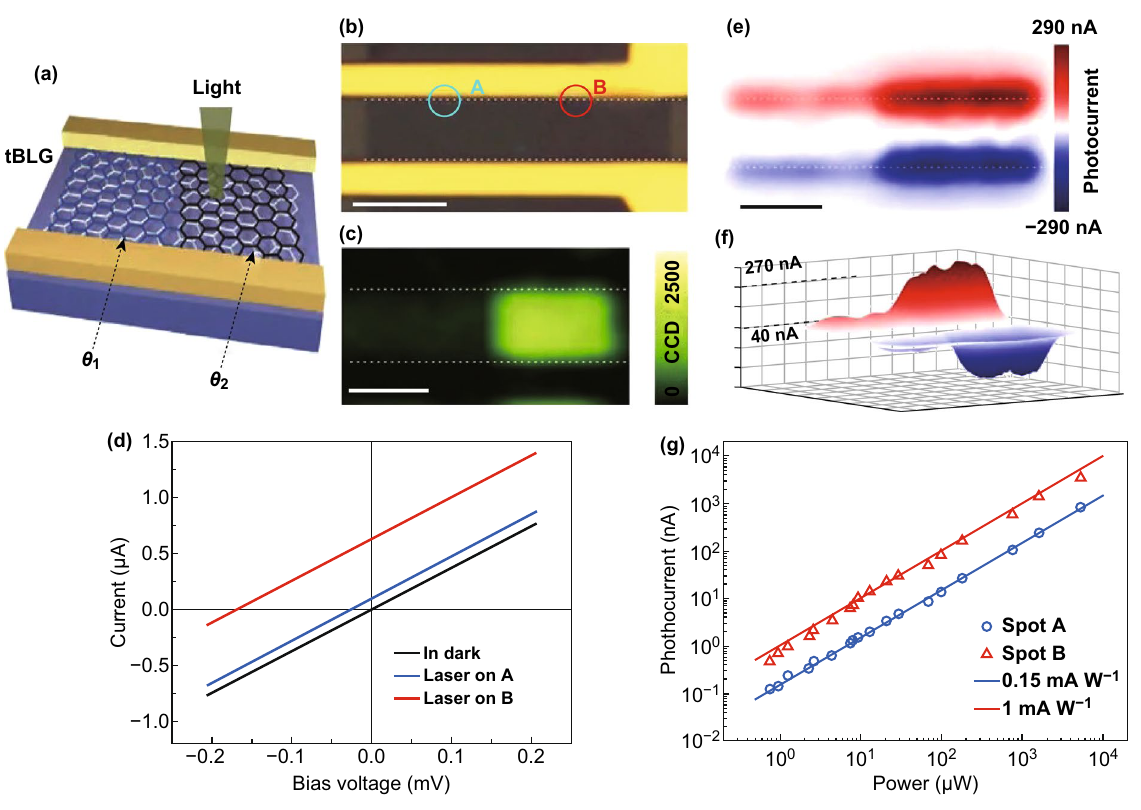
Fig. 7 a Schematic representation of a tBLG photodetection device, which comprises of two adjacent tBLG domains with different twisting angles of 7° and 13°. b Optical image of the tBLG photodetection device. c Raman G band intensity mapping image of 13° twisting angled tBLG with an enhanced G band intensity at 2.33 eV laser energy. d Current versus source–drain bias curve with laser focus on spot A of 7° and spot B of 13° twisting angle in tBLG with laser off. e , f Scanning photocurrent image and its 3D view of the tBLG device. g Photocurrents gen- erated as a function of incident power at spot A of 7° and spot B of 13° twisting angle of the tBLG device [86]. Adapted with permission from Ref.